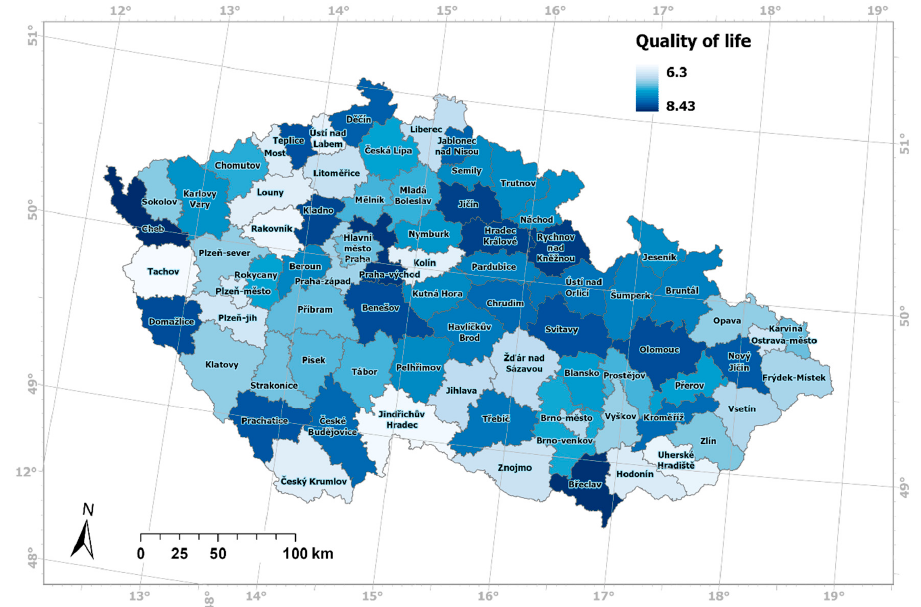
Figure 5. Spatial differentiation of quality of life in districts of Czechia.